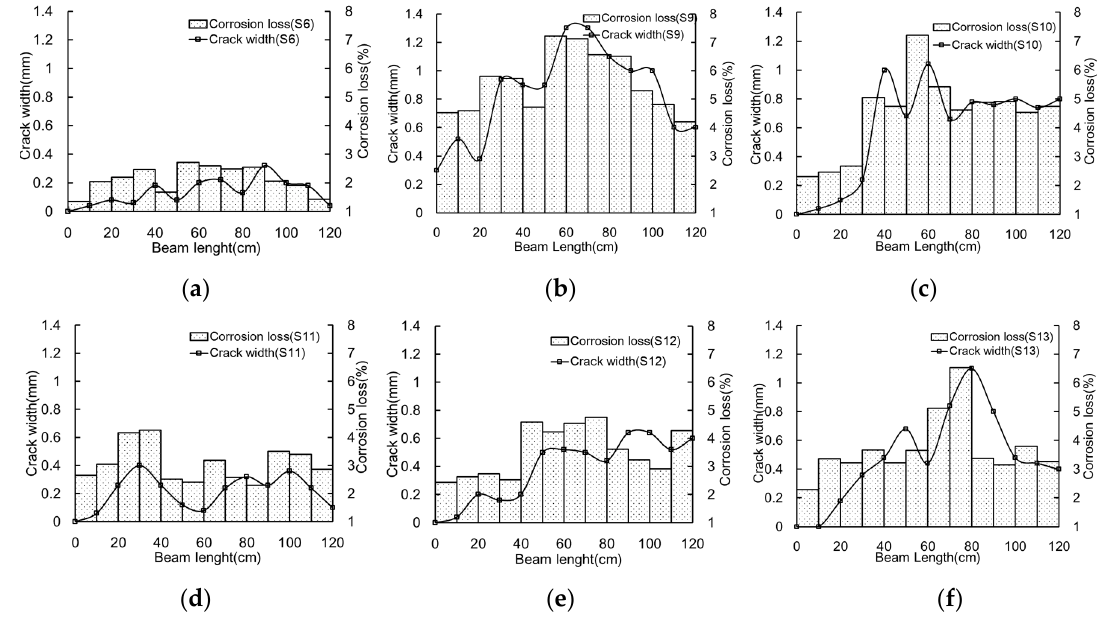
Figure 6. Crack width and corrosion loss (group S): ( a ) S6; ( b ) S9; ( c ) S10; ( d ) S11; ( e ) S12; and ( f )